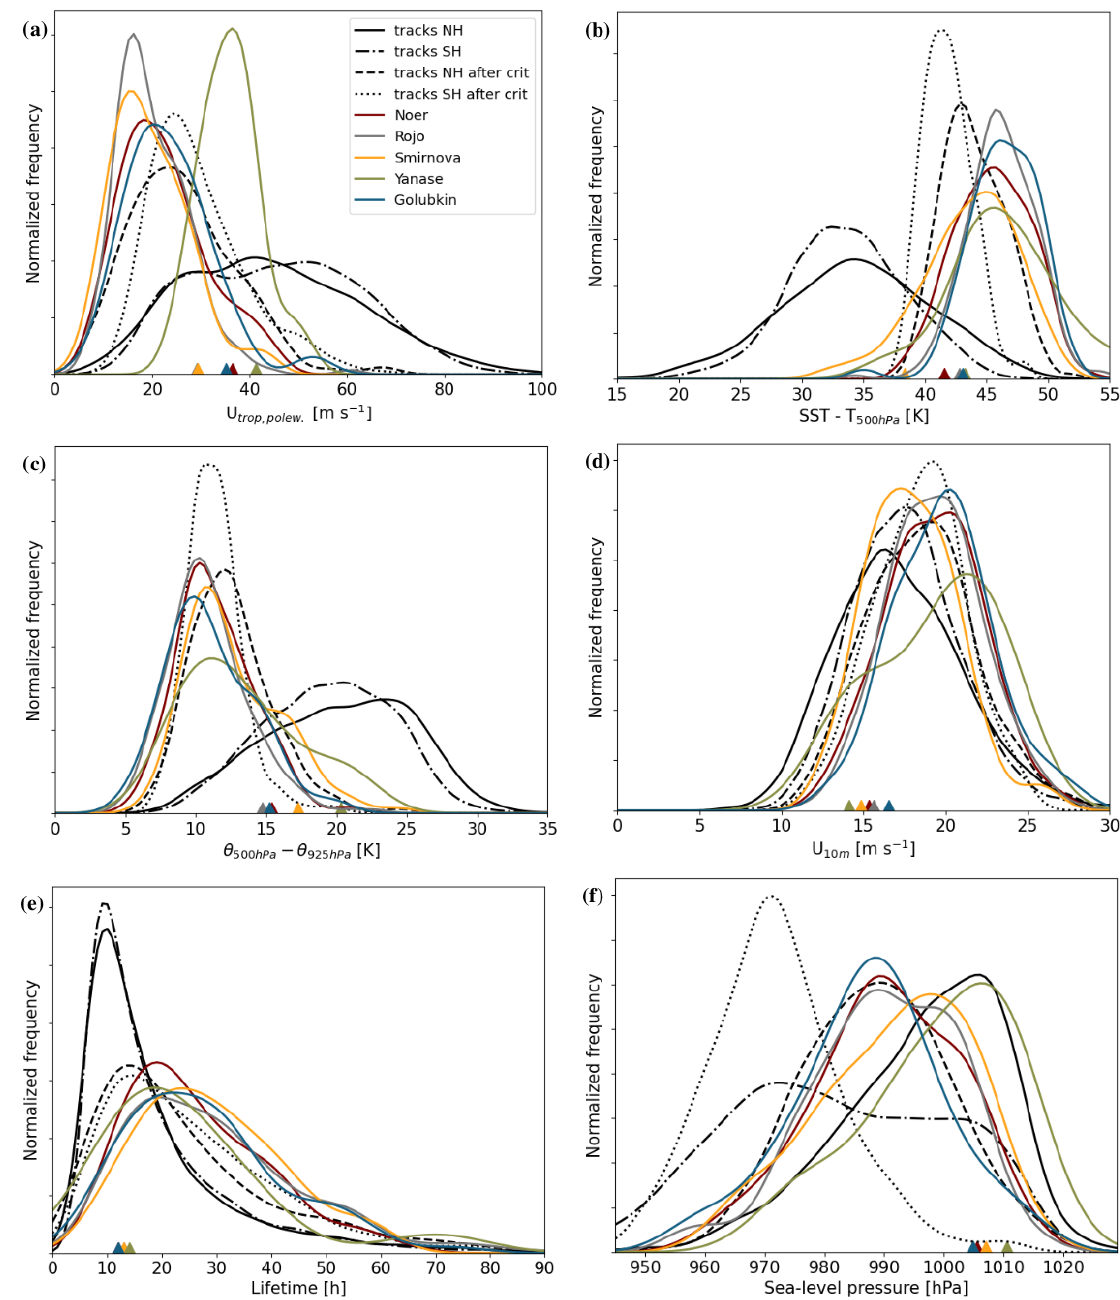
Figure 2. As Fig. 1. Parameter distributions for polar lows from the lists (colours) and cyclone tracks of the Northern Hemisphere and Southern Hemisphere (black). Cyclone tracks that remain after the application of the four polar-low criteria for the two hemispheres (black dotted and dashed) are displayed to demonstrate the quality of the polar-low criteria. (a) The maximum wind speed at the tropopause poleward of the system, U trop , polew . , is computed as the lifetime mean of the track. (b) The temperature difference between the 500hPa level and the sea surface, SST − T 500hPa , and (d) the maximum near-surface wind speed, U 10m , as the lifetime maximum. (c) The potential temperature difference between 500 and 925hPa, θ 500hPa − θ 925hPa , and (f) the sea-level pressure, as the lifetime minimum. (e) The lifetime is the duration of the